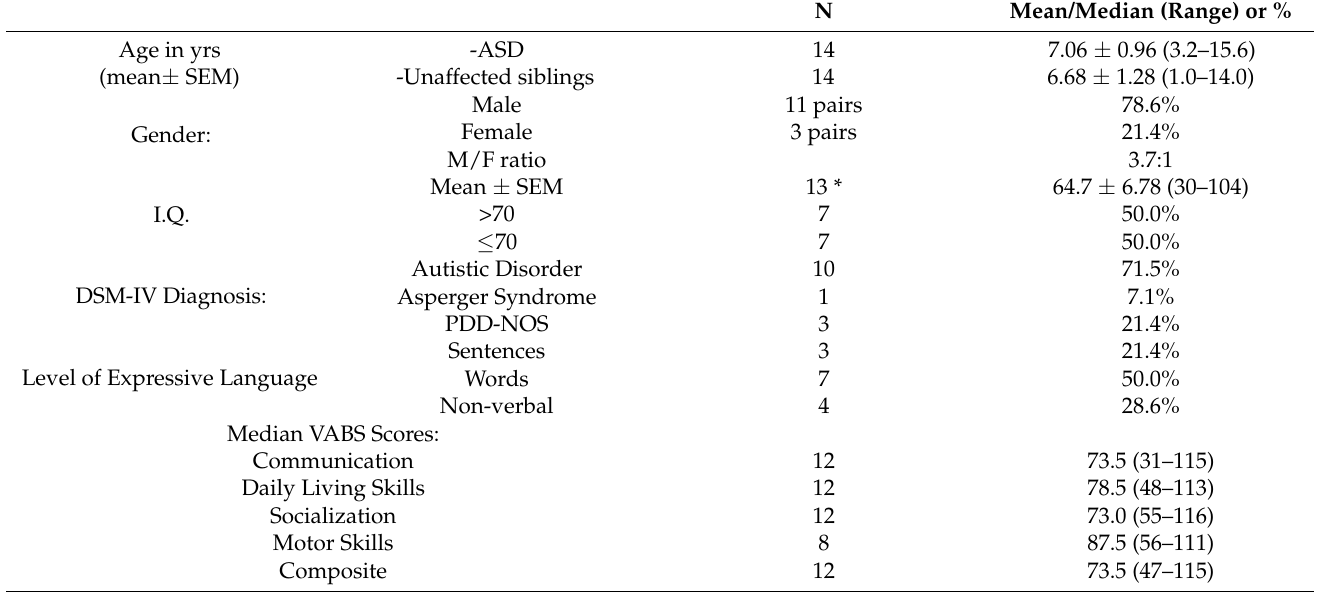
Table 1. Demographic characteristics of the sample (N = 14 ASD and 14 typically-developing siblings) and main clinical features of the 14 children with ASD. * One ASD patient with intellectual disability was not testable. Abbreviations: IQ, Intellectual Quotient; PDD-NOS, Pervasive Developmental Disorder—Not Otherwise Specified; SEM, Standard Error of the Mean; VABS, Vineland Adaptive Behavior